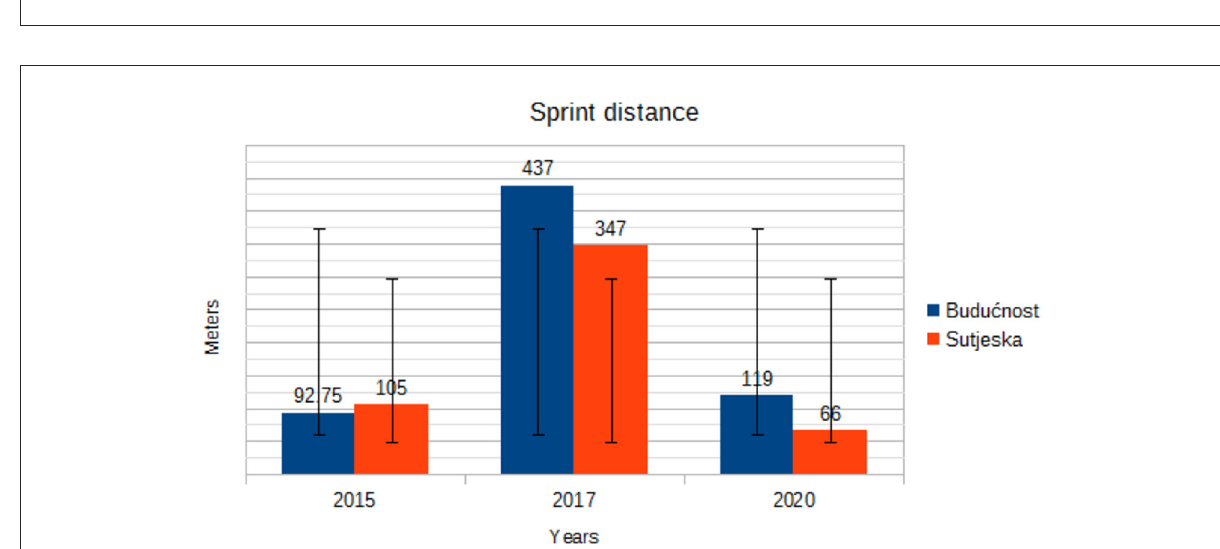
FIGURE6 Trend in mean sprint distance by